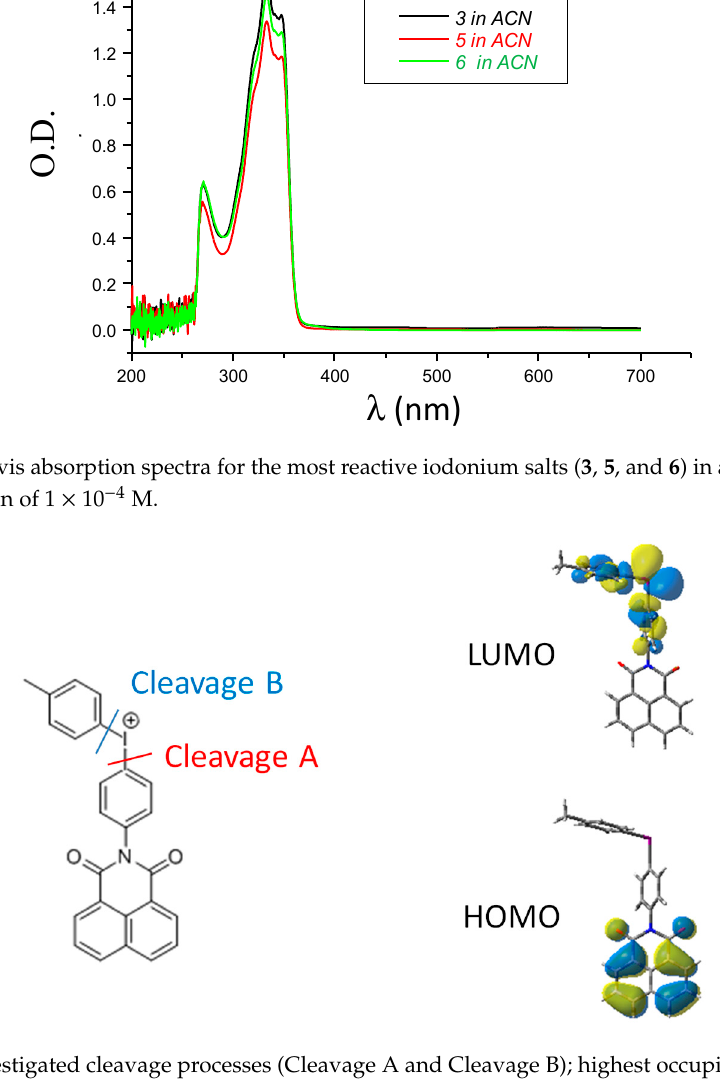
Figure 5. Investigated cleavage processes (Cleavage A and Cleavage B); highest occupied and lowest unoccupied molecular orbitals (HOMO and LUMO),